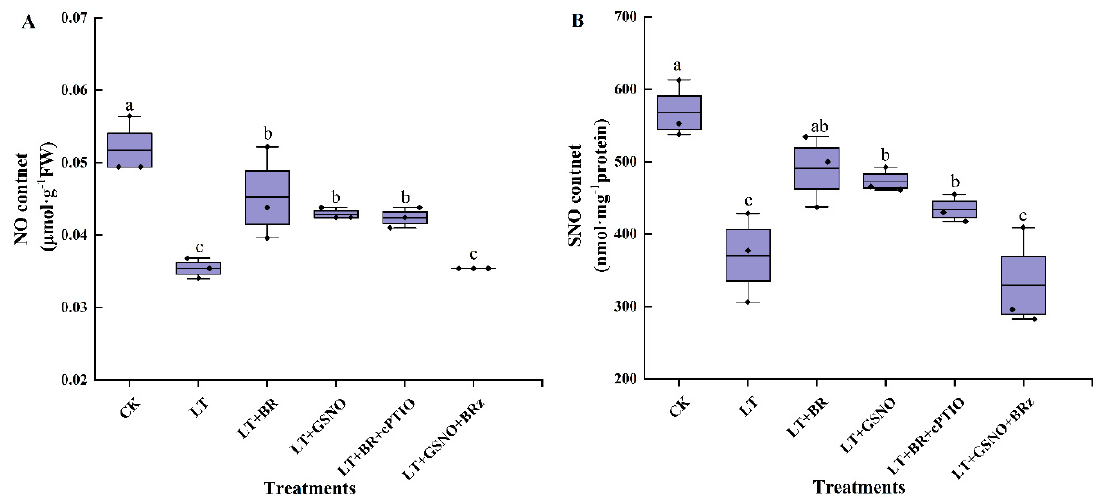
Figure 4. Effects of BR, GSNO, cPTIO and BRz treatments on NO content and SNO content of mini Chinese cabbage under low-temperature stress. Five-leaf seedlings were treated with CK (26/18 °C, day/night), LT (4/4 °C, day/night), LT + 0.05 mg/L BR, LT + 50 µM GSNO, LT + 0.05 mg/L BR + 50 µM cPTIO and LT + 50 µM GSNO + 10 µM BRz, cPTIO and BRz were sprayed separately, and then BR and NO were sprayed after an interval of 5 h, once every day for 3 d and treated for 7 d. After treating for 7 d, NO and SNO contents were measured, respectively. ( A ) NO content. ( B ) SNO content. Different lowercase letters above the error bars indicate significant differences at the 0.05 level ( p ≤ 0.05).